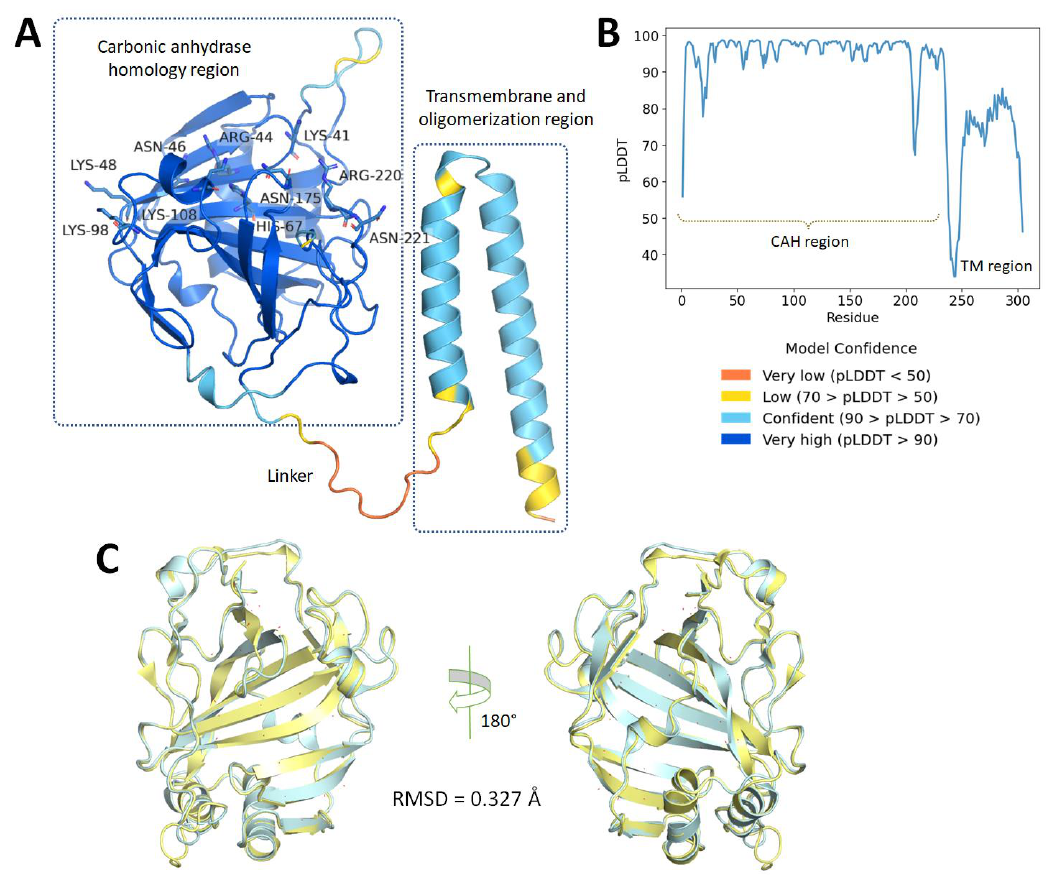
Figure 2. The homology structure of the MPXV E8 protein: ( A ) The model consists of two distin- guished regions: (I) Carbonic anhydrase homology (CAH) region, and (II) transmembrane (TM) and oligomerization region. The basic residues that were hypothesized to be a binding pocket of chon- droitin sulfate are represented as sticks. ( B ) The predicted local-distance difference test (pLDDT) values over 304 residues of the MPXV E8 protein (the higher the value is, the better confidence the model has). ( C ) The three-dimensional structure of the MPXV E8 protein (yellow cartoon) aligned with the VACV D8 protein (PDB ID: 4E9O) (blue cartoon) with the root mean square deviation (RMSD) value.